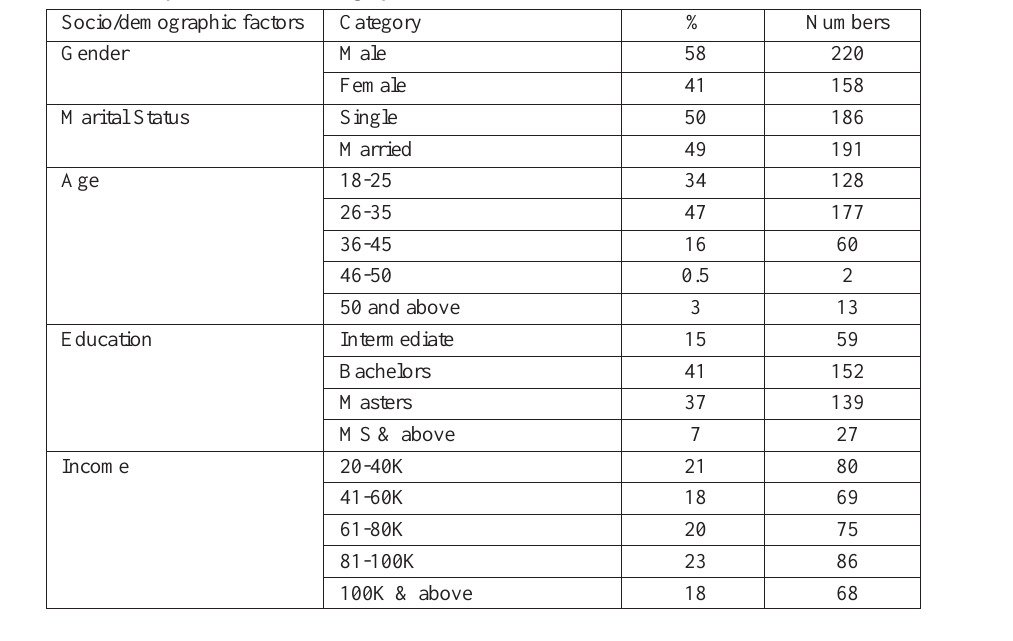
Table 2: Respondent’s Socio/demographic